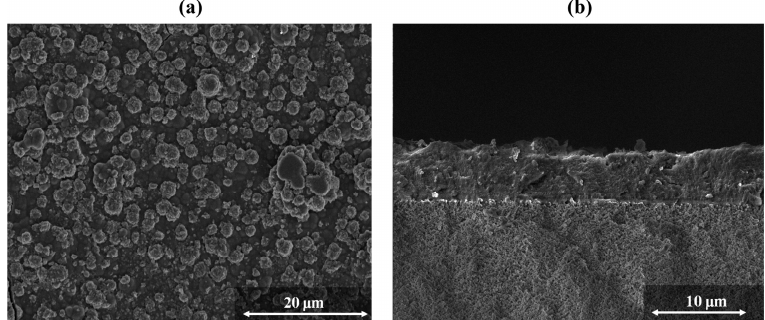
Figure 18. ( a ) Top view and ( b ) cross-section SEM image of ZIF-8 membrane grown on alumina support using the spin coating approach (adapted with permission from ref.